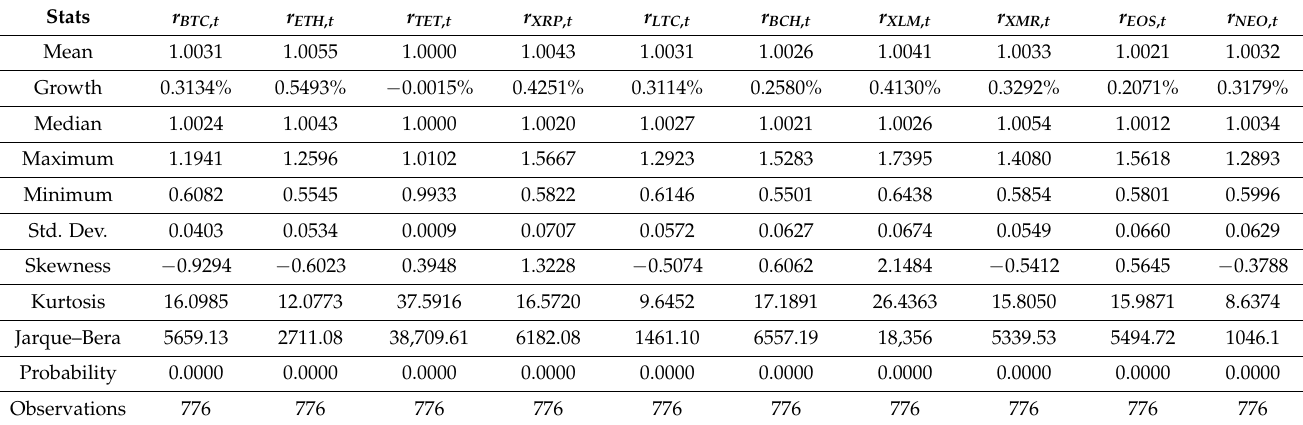
Table 4. Descriptive statistics of the 10 cryptocurrencies’ return indices for the COVID-19